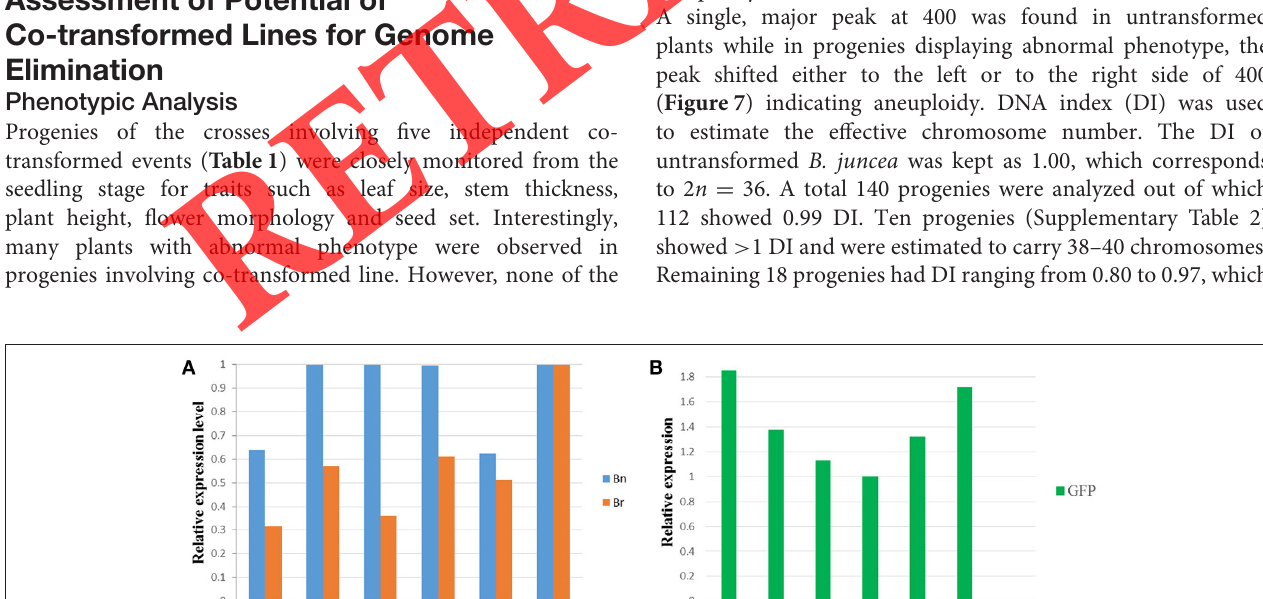
Frontiers in Plant Science |